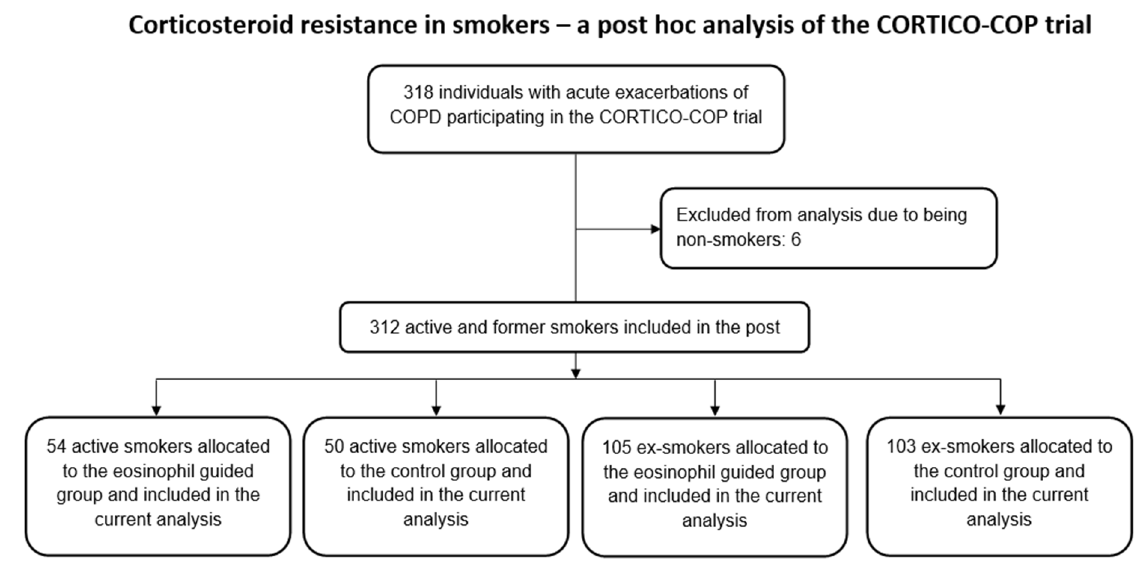
Figure 1. Study flowchart.